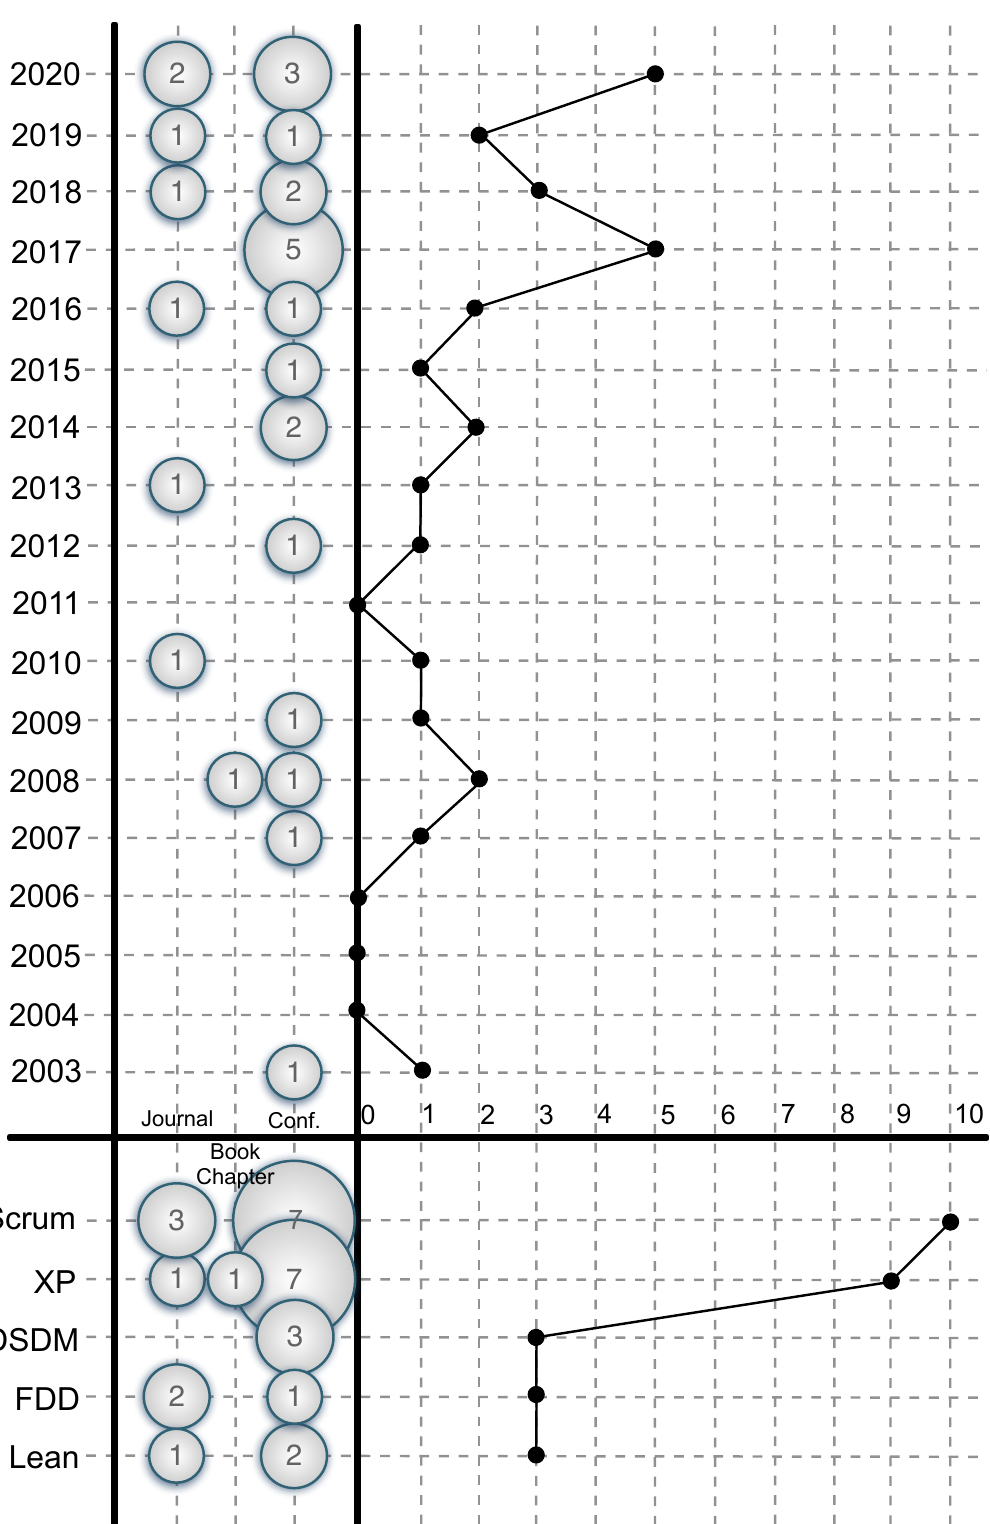
Figure 2. Mapping for the primary study distribution between the different agile process categories along the year and type of publication (answer to